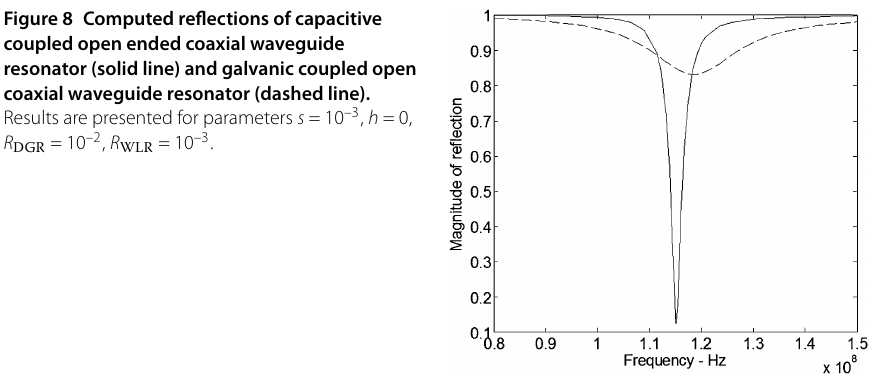
Figure 8 Computed reflections of capacitive coupled open ended coaxial waveguide resonator (solid line) and galvanic coupled open coaxial waveguide resonator (dashed line). Results are presented for parameters s = 10 –3 , h = 0, R DGR = 10 –2 , R WLR = 10 –3